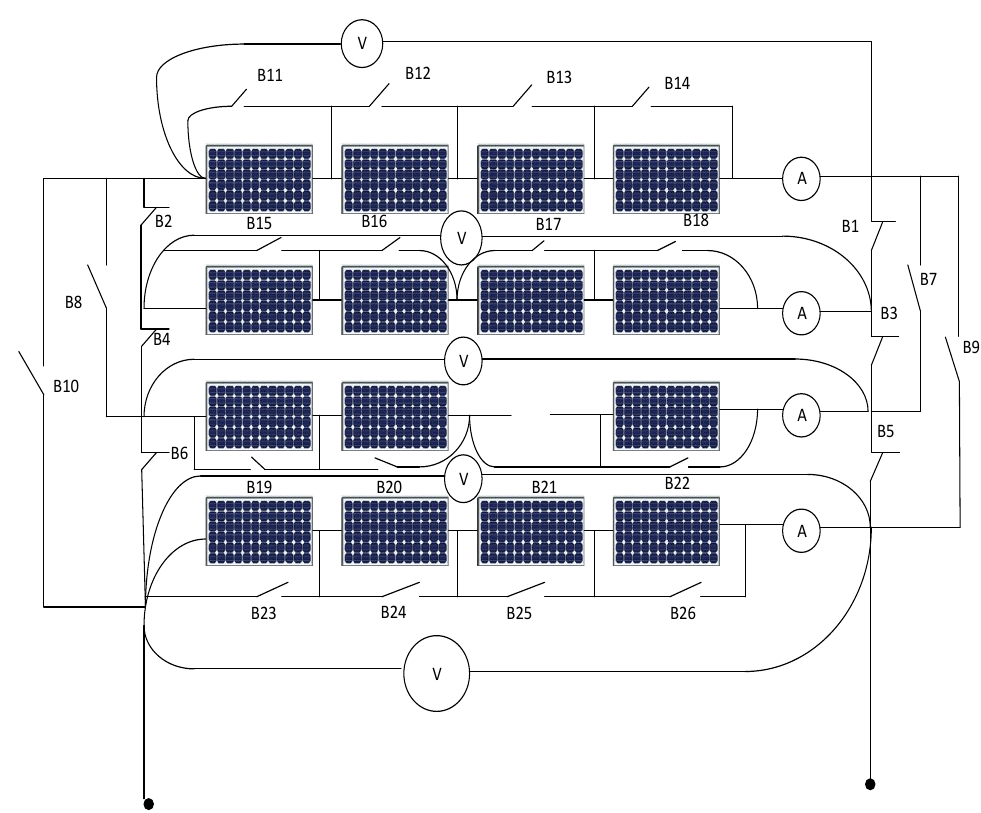
Figure 12. Construction of PV array during faulted PV group.